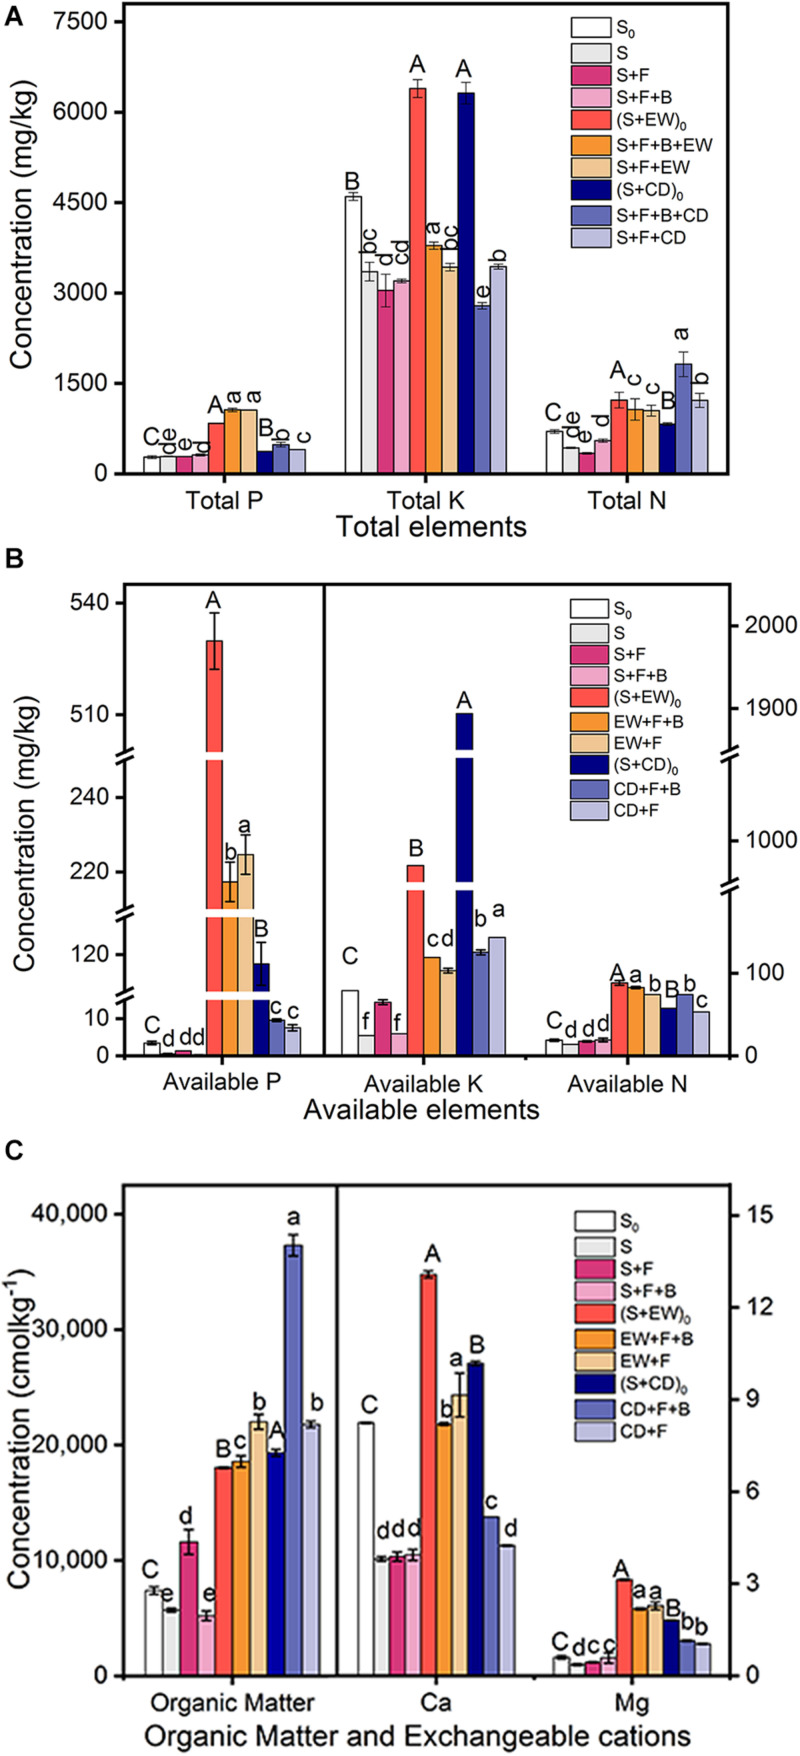
Contents (mg/kg) of mineral nutrients in the soil in the pot experiment. (A) Total elements: TP, TK, and TN; (B) available elements: AP, AK, and AN; (C) organic matter (OM), Ca, and Mg. Values are the mean ± SD of three replicates. S0, initial soil; (S + EW)0, initial soil combined 10% (w/w) wormcast; (S + CD)0, initial soil combined 10% (w/w) cow dung compost; S, healthy control (healthy soil); S + F, disease control (healthy soil + FOC4); S + F + B, healthy soil + FOC4 + HN03 treatment; S + F + B + EW, healthy soil + FOC4 + HN03 + wormcast treatment; S + F + EW, healthy soil + FOC4 + wormcast treatment; S + F + B + CD, healthy soil + FOC4 + HN03 + cow dung compost treatment; S + F + CD, healthy soil + FOC4 + cow dung compost treatment. In the graph, capital letters indicate significant differences in original soil properties, and lowercase letters indicate significant differences in the potting soil in the different treatments. Bars sharing the same letter are not significantly different based on Tukey’s test at P < 0.05.